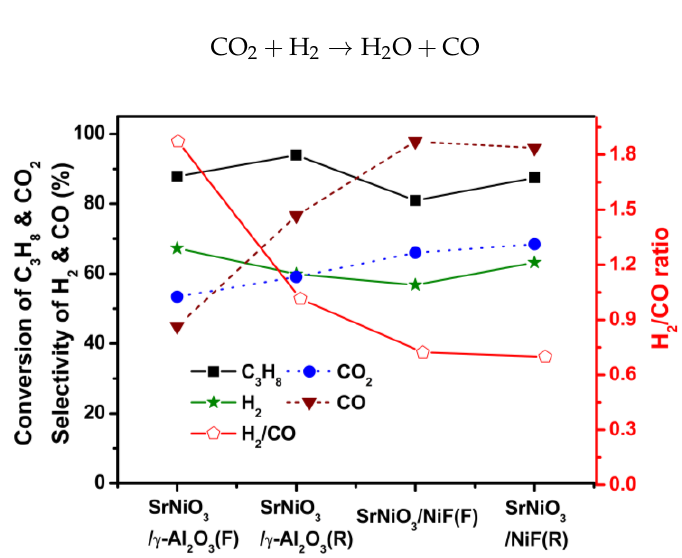
Figure 9. Catalytic performance of DRP over SrNiO 3 / γ -Al 2 O 3 (F and R) and SrNiO 3 /NiF (F and R) catalysts at 700 °C, CPR = 3 (30:10:60 CO 2 :C 3 H 8 :Ar) and total flow rate = 200 mL/min.